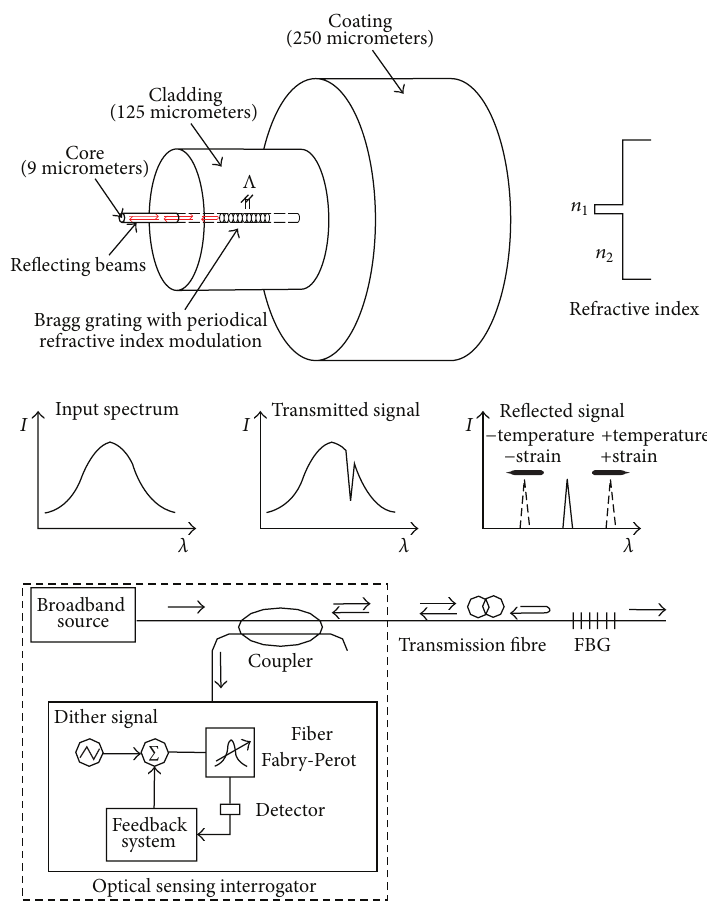
Figure 1: Strain and temperature sensing of an FBG